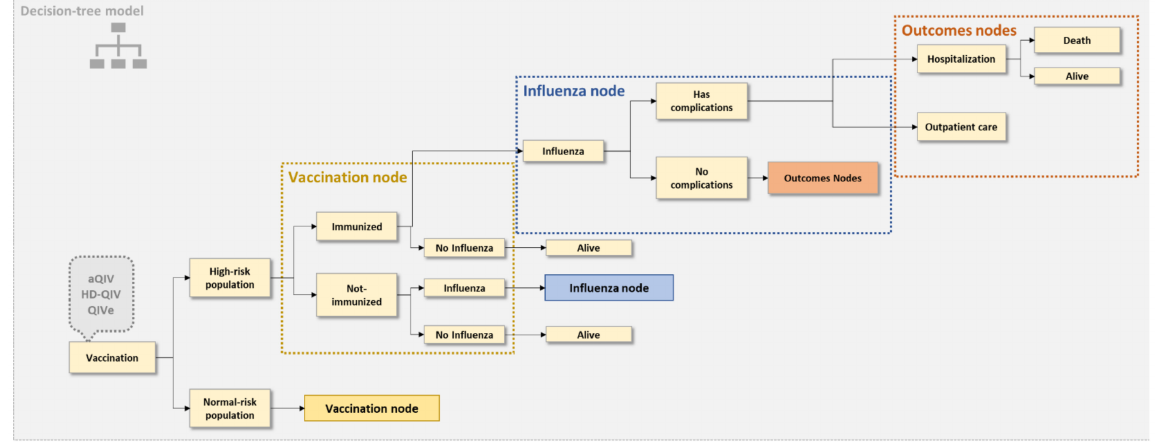
Figure 1. Model structure. aQIV—MF59 ® -adjuvanted quadrivalent influenza vaccine; HD-QIV—high-dose quadrivalent influenza vaccine; QIV—standard quadrivalent influenza